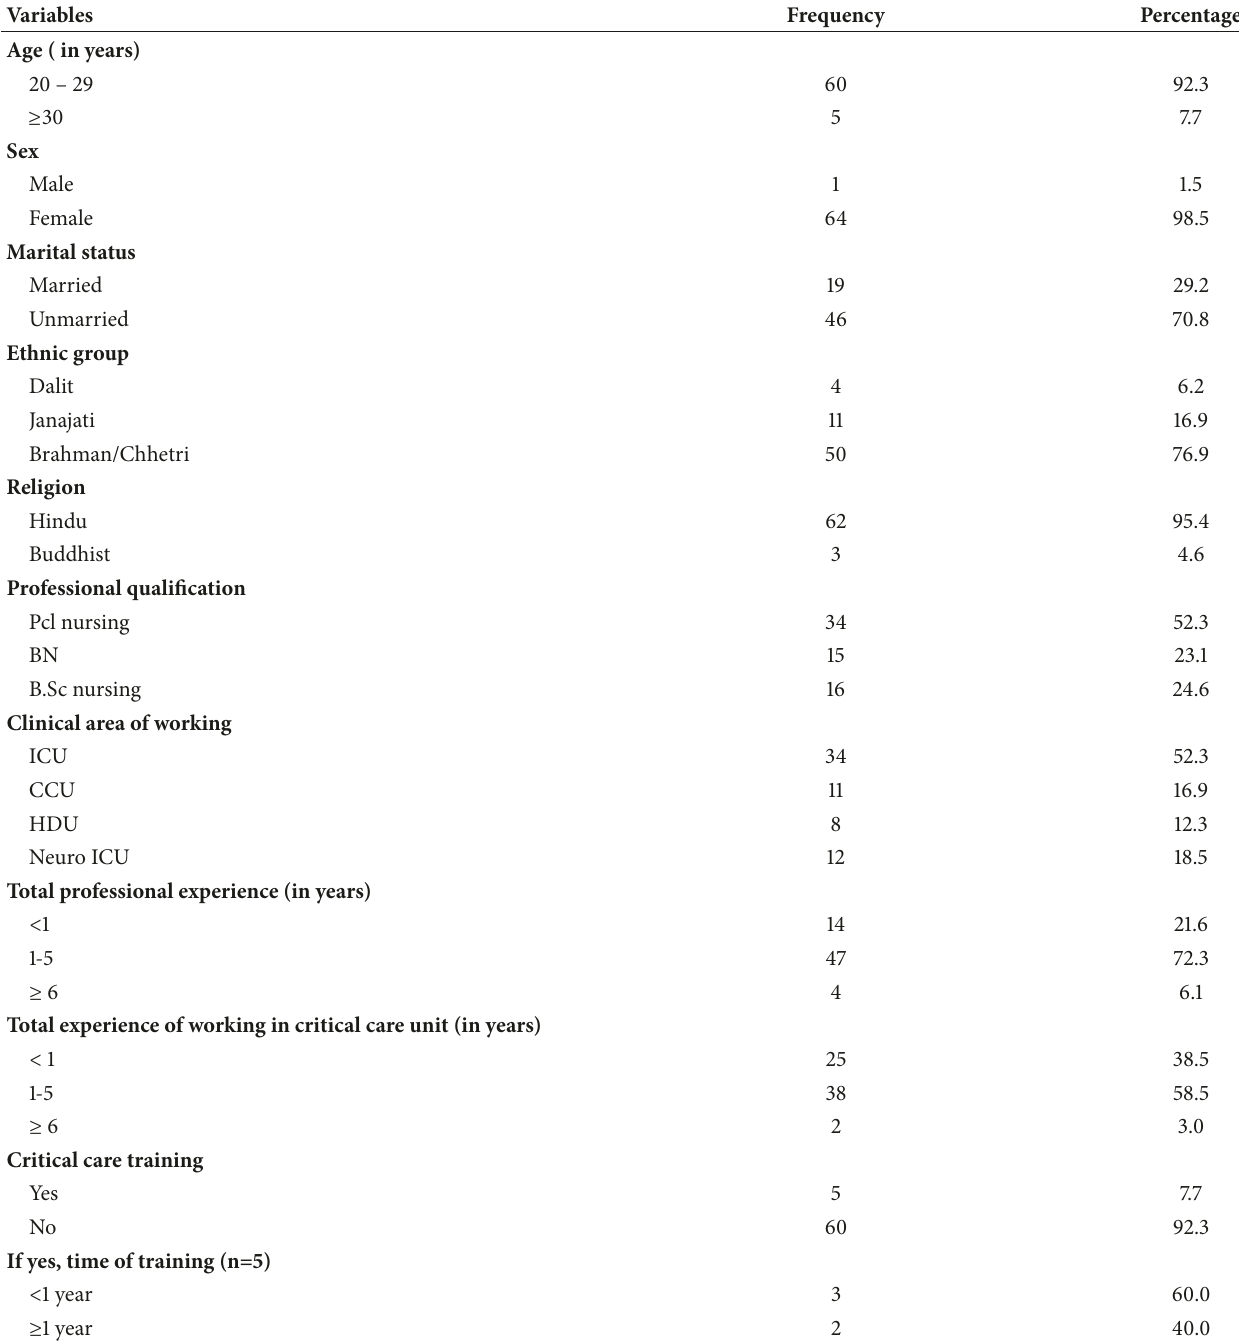
Table 1: Sociodemographic characteristics of